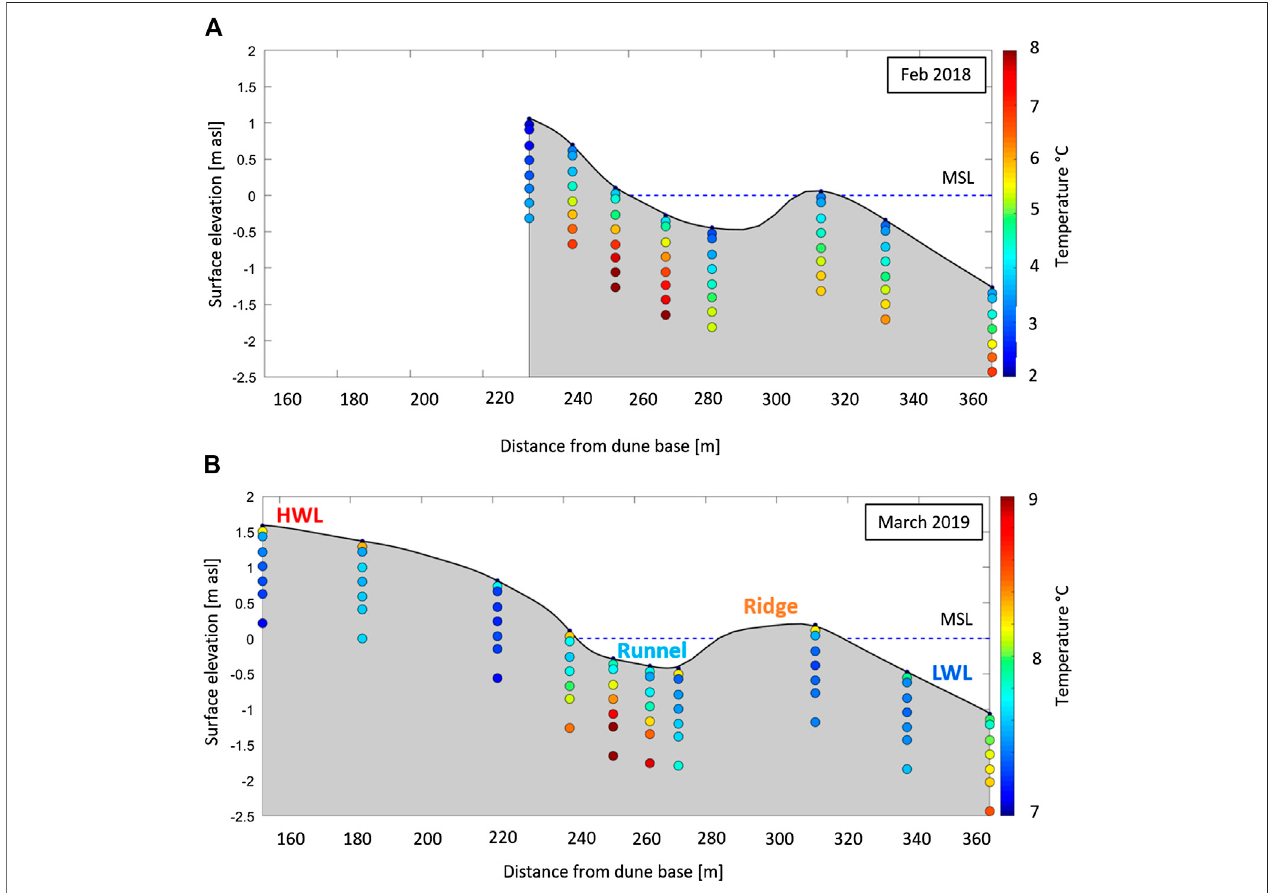
FIGURE 2 | Measured temperature pro fi les for (A) February 2018 and (B) March 2019. Ex fi ltrating conditions are assumed to occur, where porewater ’ s temperaturesarehigherin ∼ 2 mdepthcompared tothetopanddecreases towardthesurface.In fi ltration conditionsareassumedtooccur,wheretemperaturesensors show almost continuous temperature of seawater from top to 2 m